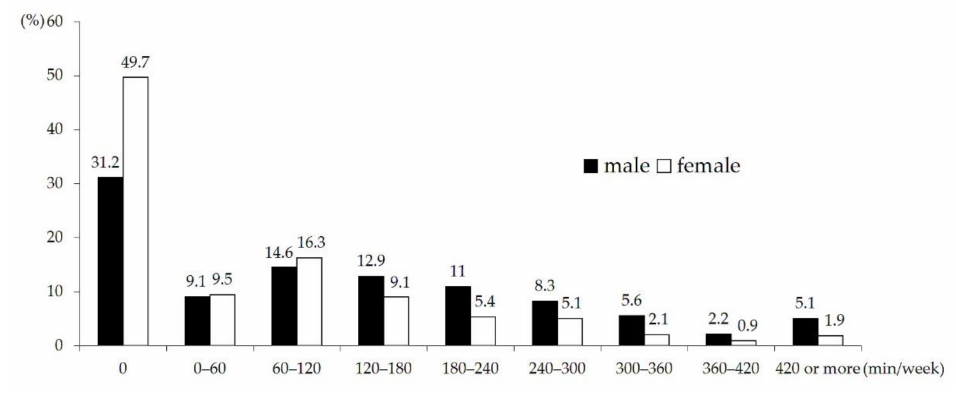
Figure 2. Distribution of physical activity. Table 2 lists the milk intake and physical activity time of each group. Because the sub- jects were classified according to whether they consumed milk or not, the daily milk intake of the no milk intake groups (M no P low , M no P high ) was 0 mL. In the milk intake groups, the milk intake levels for males in the M yes P low and M yes P high groups were 360.1 mL and 349.0 mL, respectively. For females, the milk intake levels in the M yes P low and M yes P high were 280.8 mL and 278.8 mL, respectively. There was a large difference in the physical activity time between the high-level physical activity groups (M no P high , M yes P high ) and low-level physical activity groups (M no P low , M yes P low ). For groups with high physical ac- tivity, weekly physical activity time among males was 227.3 min for M no P high and 230 min for M yes P low . Among females, the physical activity time in the M no P high and M yes P high groups was 130.7 min and 175.9 min per week, respectively. The weekly physical activity time among males was 11.8 ± 1.9 min for M no P low and 26.3 ± 3.7 min for M yes P low . Table 2. Milk intake and physical activity according to the